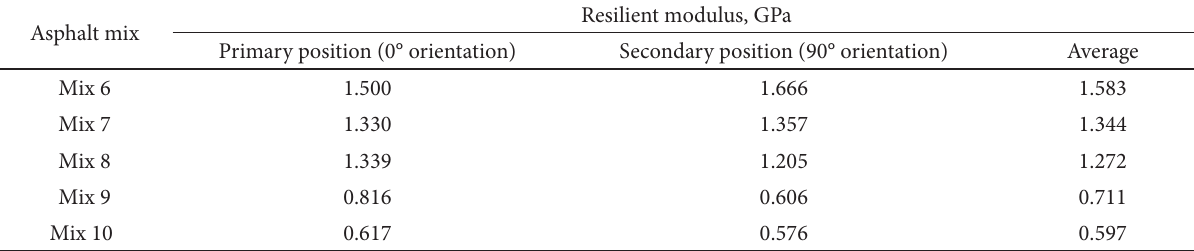
Table 4. Resilient modulus test results for different HMA mixes Asphalt mix